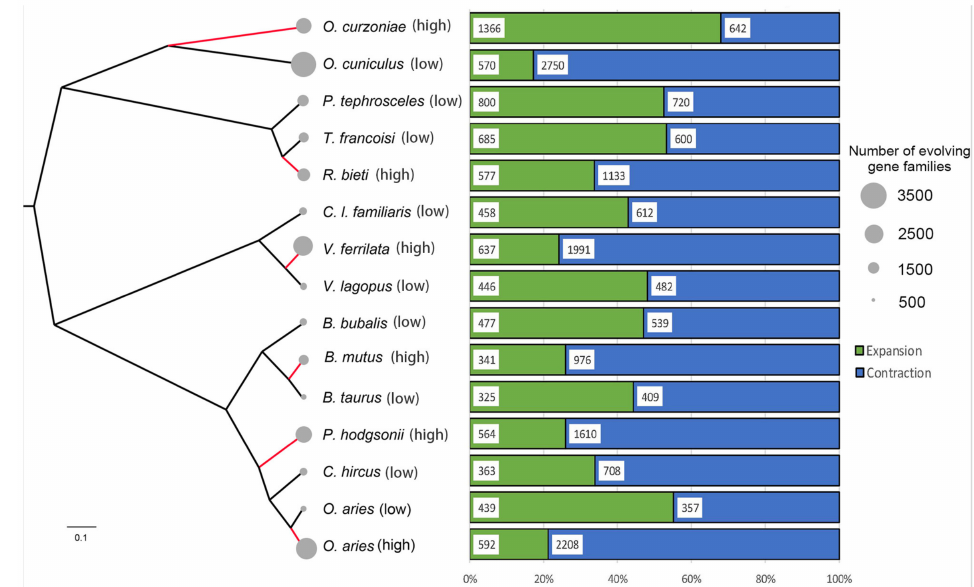
Figure 2. Gene family expansion and contraction in six high-altitude species and their relatives. The different areas of the gray circles to the left of each species name represent the number of gene families changed, where the larger the area, the greater the number of gene families changed. The green and blue rectangles represent the proportion of expanded and contracted gene families in each species to the total number of changed gene families in that